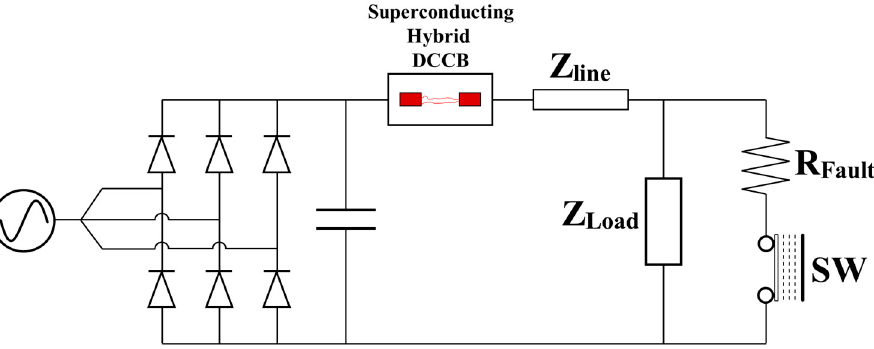
Figure 5. Simulated DC system for the review of the proposed superconducting hybrid DCCB.